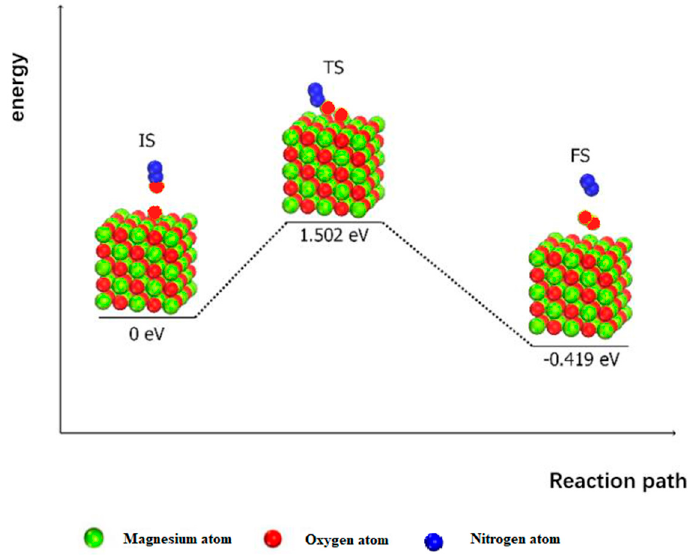
Figure 6. The surface reduction process of MgO (100) following the Eley–Rideal (ER) mechanism.